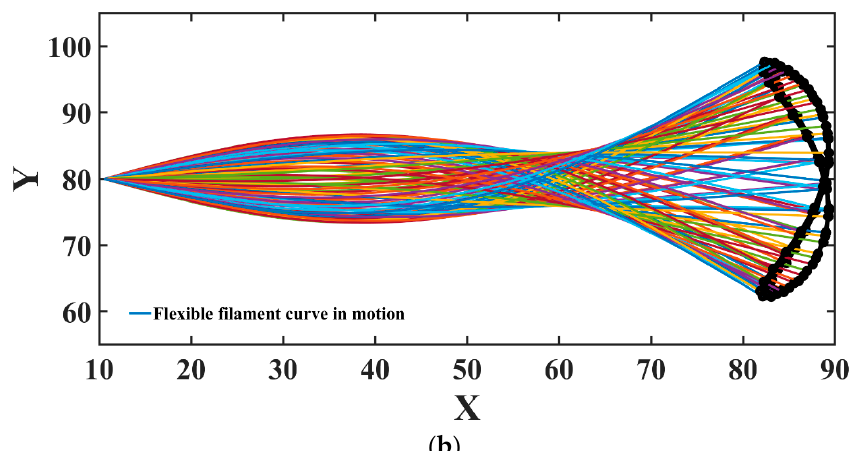
Figure 10. The filament motion trajectory diagrams: ( a ) K b = 0.08; ( b ) K b = 0.11.